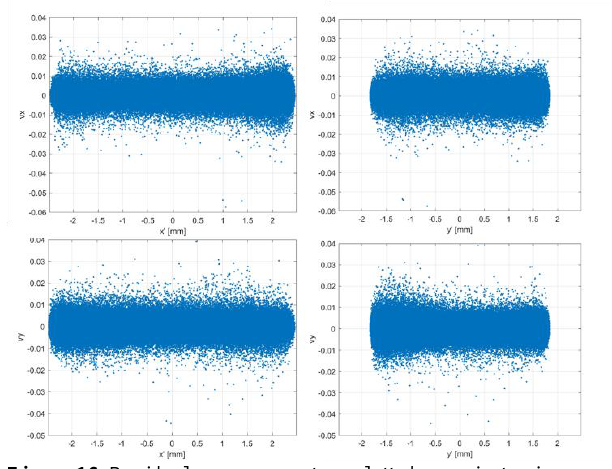
Figure 15. Residual plots from IAPG bundle adjustment with B and B+O for iPhoneX (data set 7); vector scale 100.